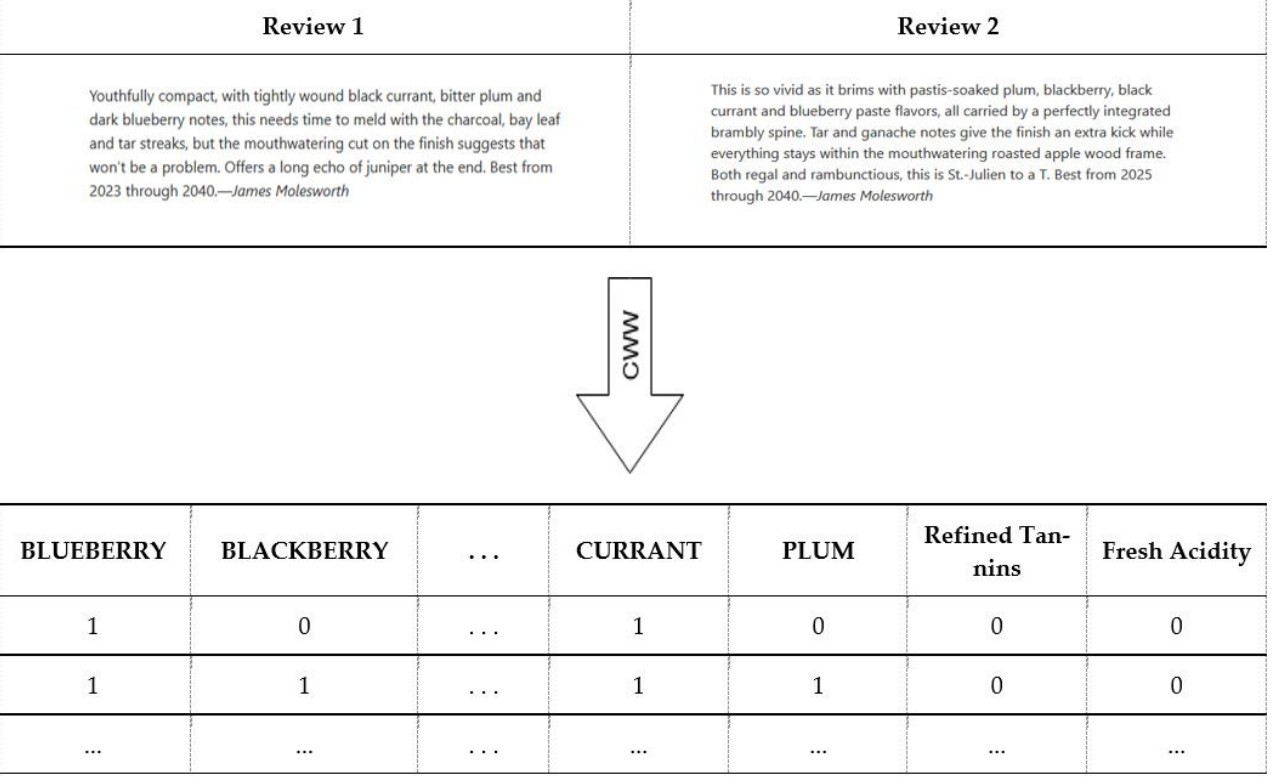
Figure 2. The flowchart of review conversion into a machine-understandable format by the Computational Wine Wheel. The Computational Wine Wheel (CWW) is a dictionary-based natural language processing tool for the automatic extraction of key attributes from human-language wine reviews into machine-understandable binary data.